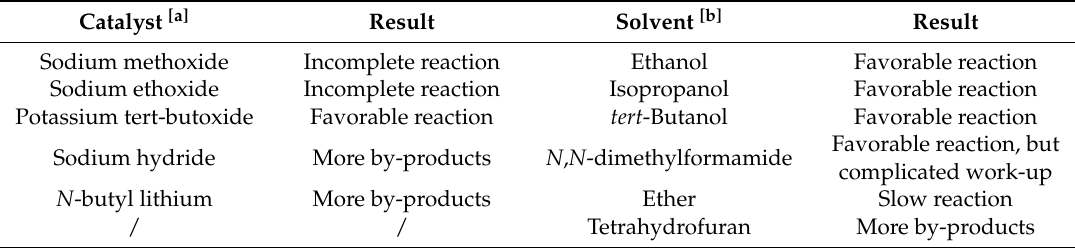
Table 1. Different results caused by the catalysts and solvents used in condensation reaction.